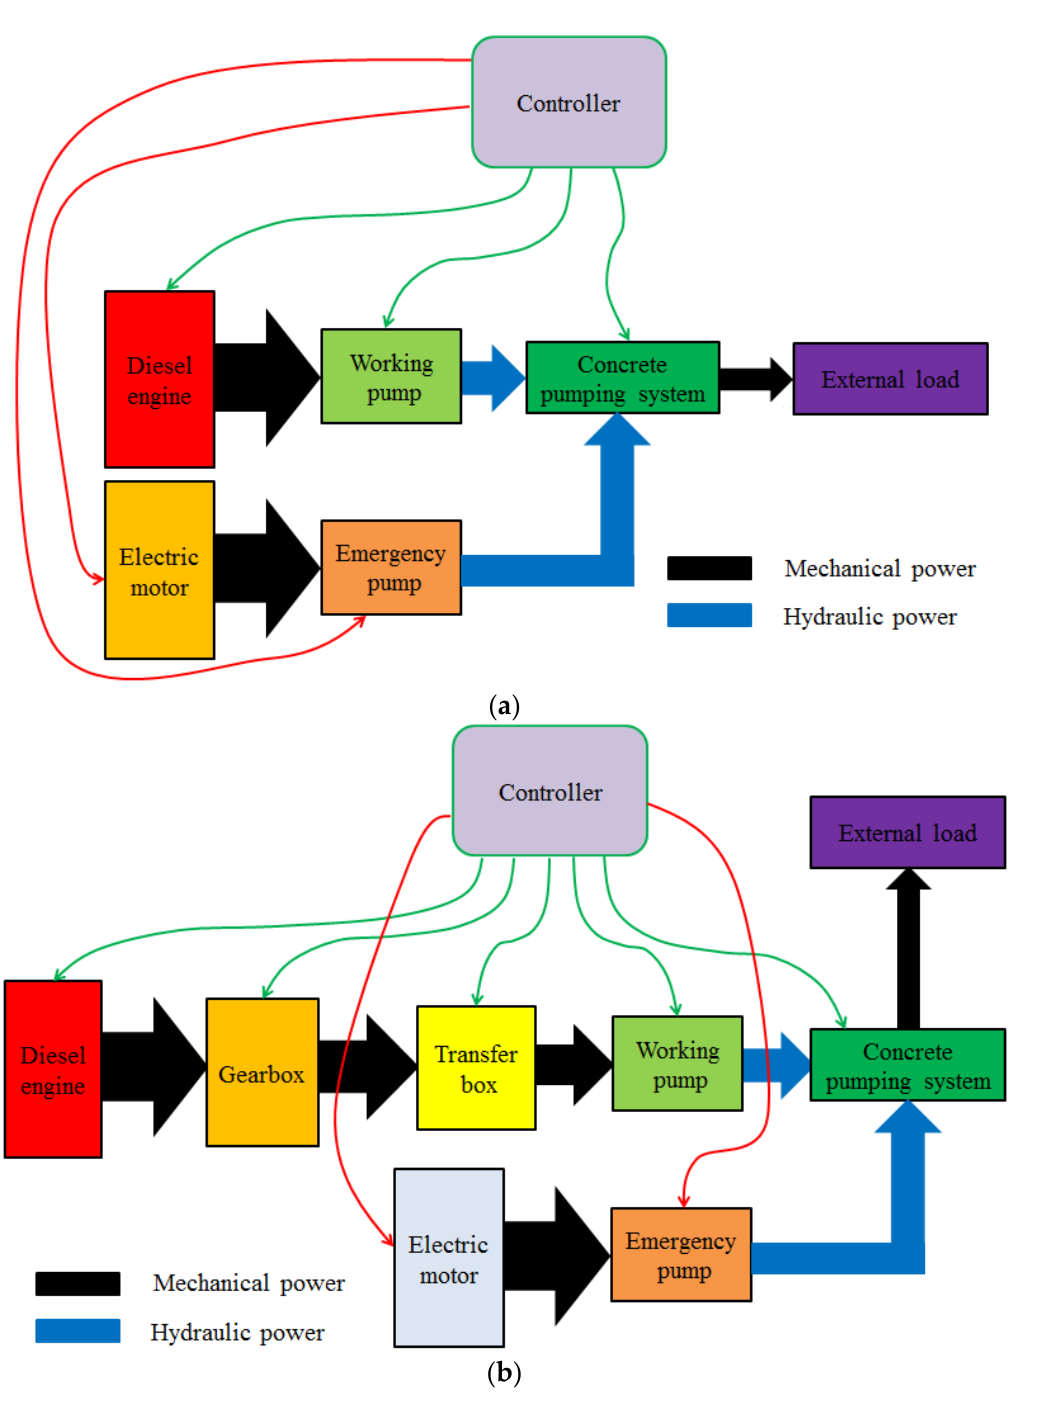
Figure 11. Schematic of dual-power approach of energy conservation for concrete pumps. ( a ) Dual-power approach of trailer concrete pump. ( b ) Dual-power approach of transported/truck-mounted concrete pump.